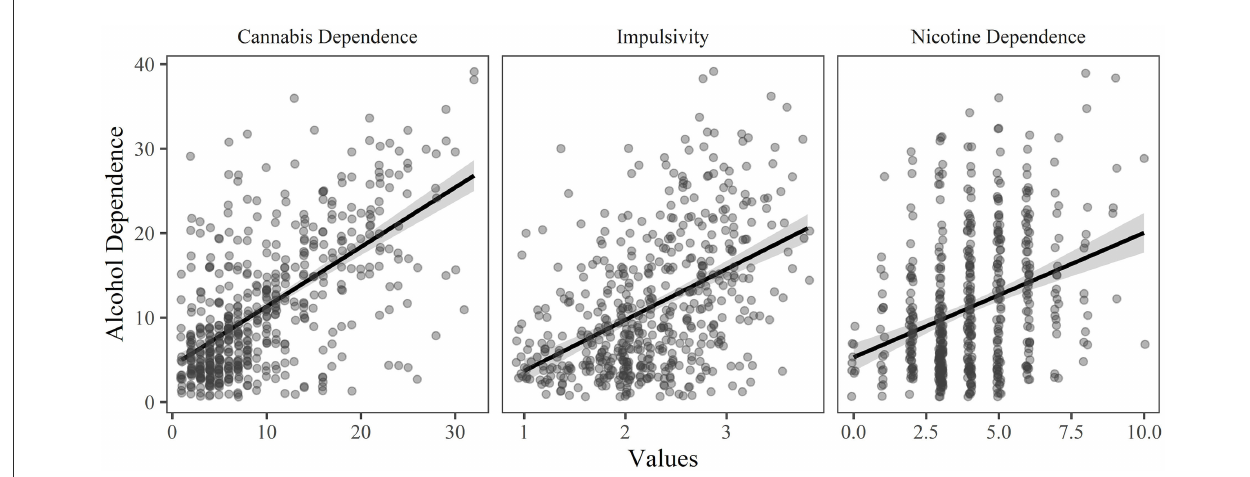
FIGURE1 The relationship between alcohol dependence and each of the significant predictor variables ( p < 0.05 and relative importance ≥ 0.02) in the final model of the hierarchical regression, holding all other variables constant.